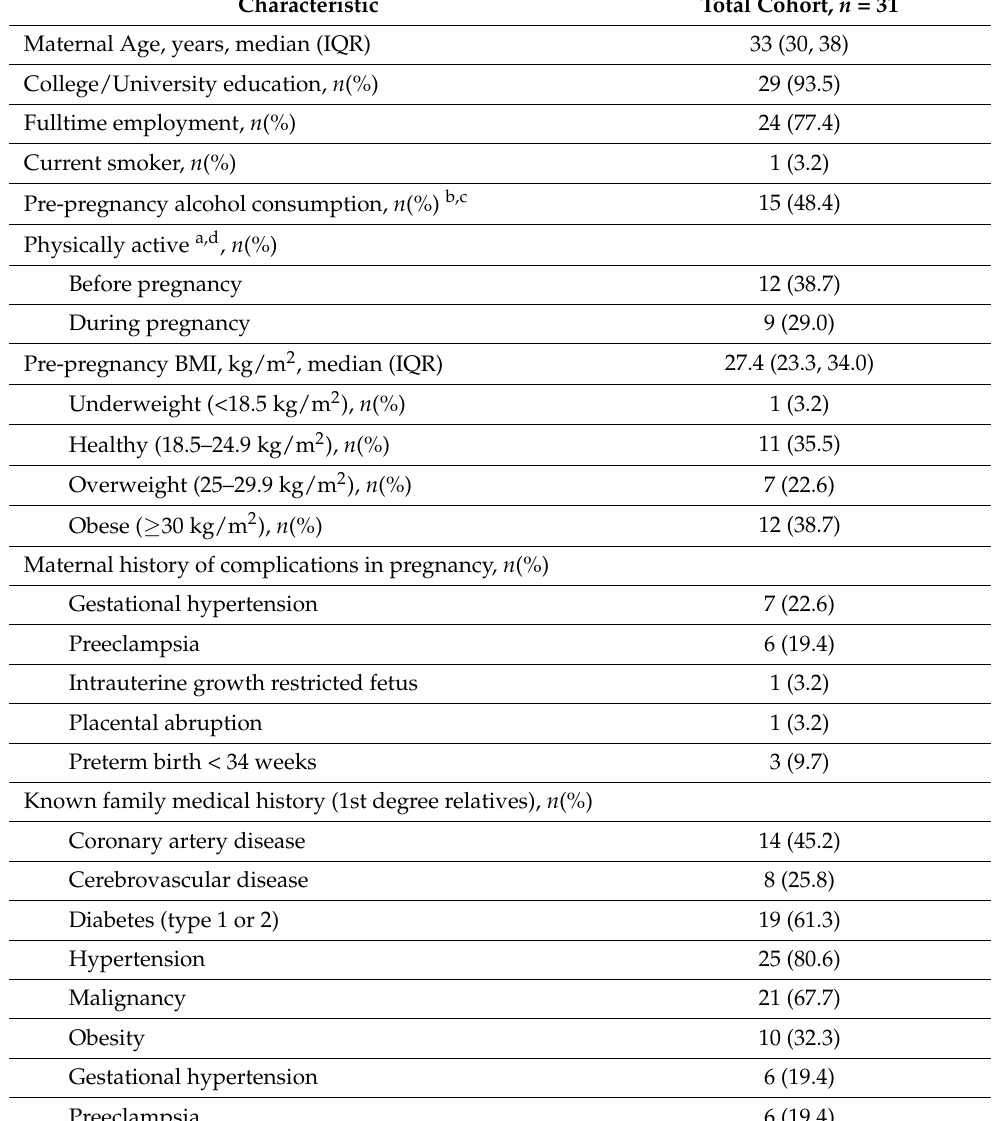
Table 2. Baseline characteristics of study